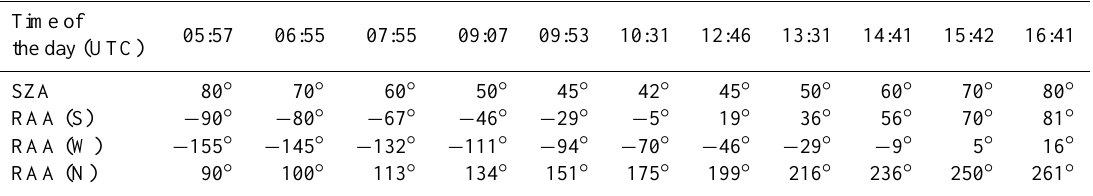
Table 1. Selected times of the day and corresponding solar zenith angles (SZA) and relative azimuth angles (RAA) angles, for which radiative transfer simulations are performed.